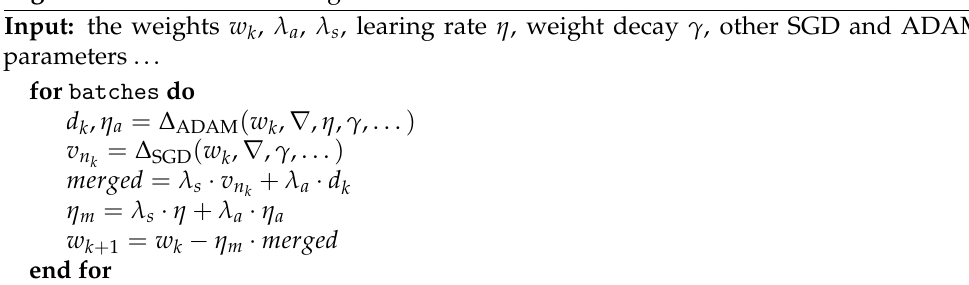
Algorithm 3 ATMO on mixing ADAM and